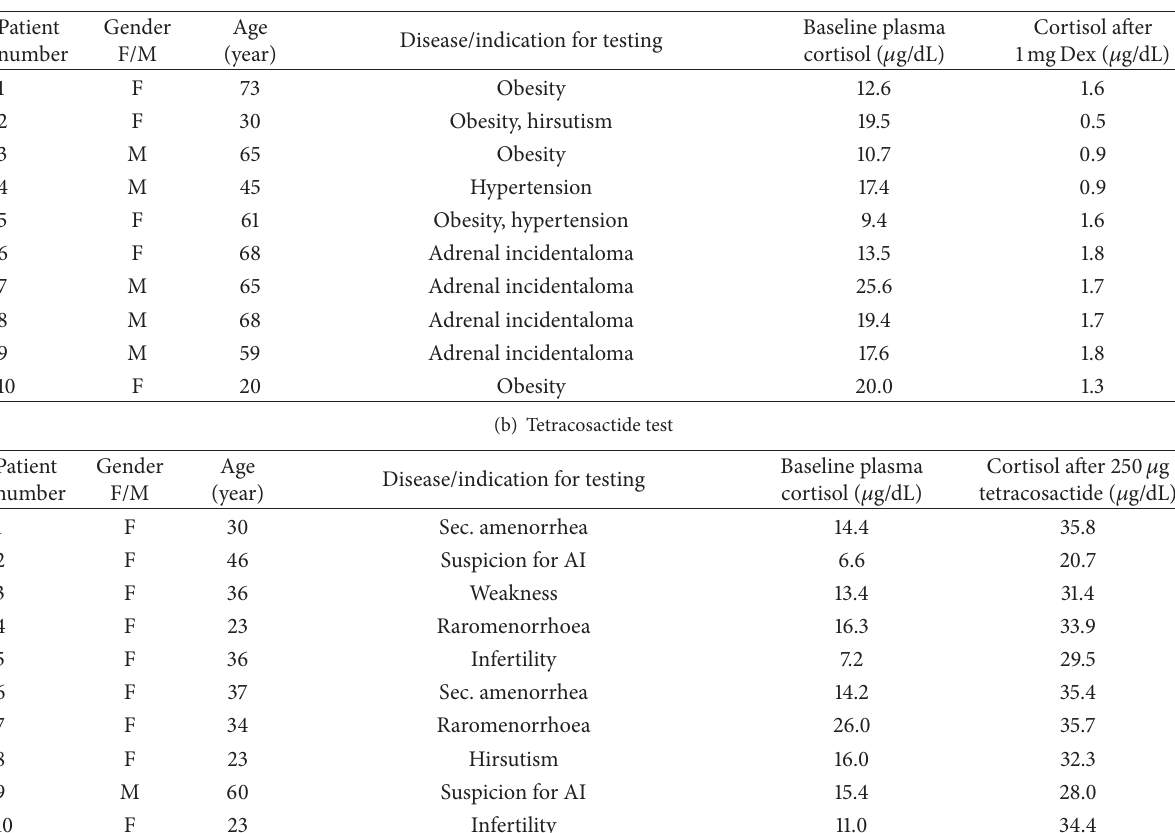
Table 1: Characteristics of